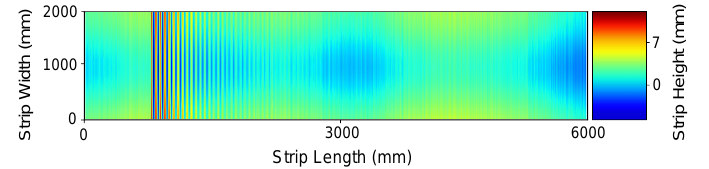
Figure 3. Synthetic flatness sensor data. (Color